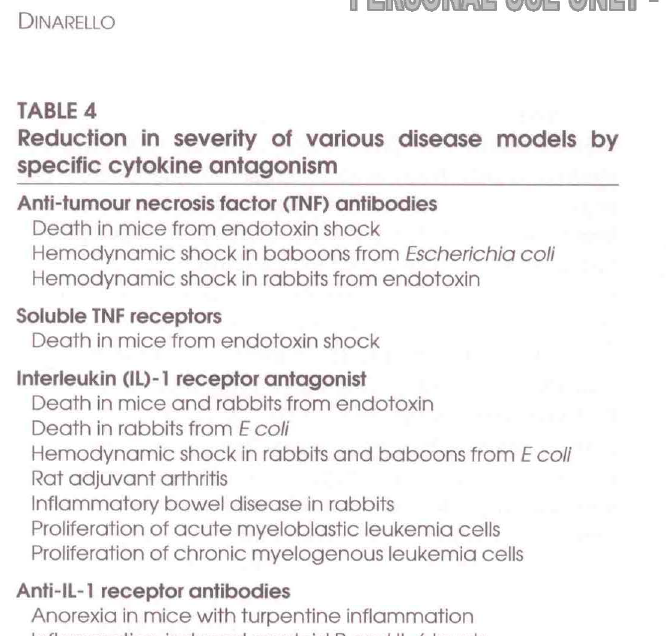
Reduction in severity of various disease models by specific cytokine